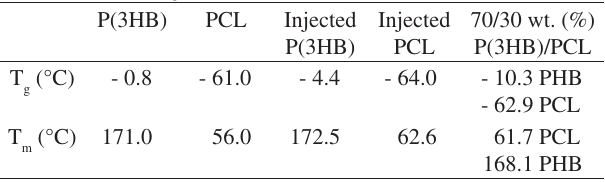
and T ) for P(3HB), PCL and 70/30 P(3HB)/PCL. g m